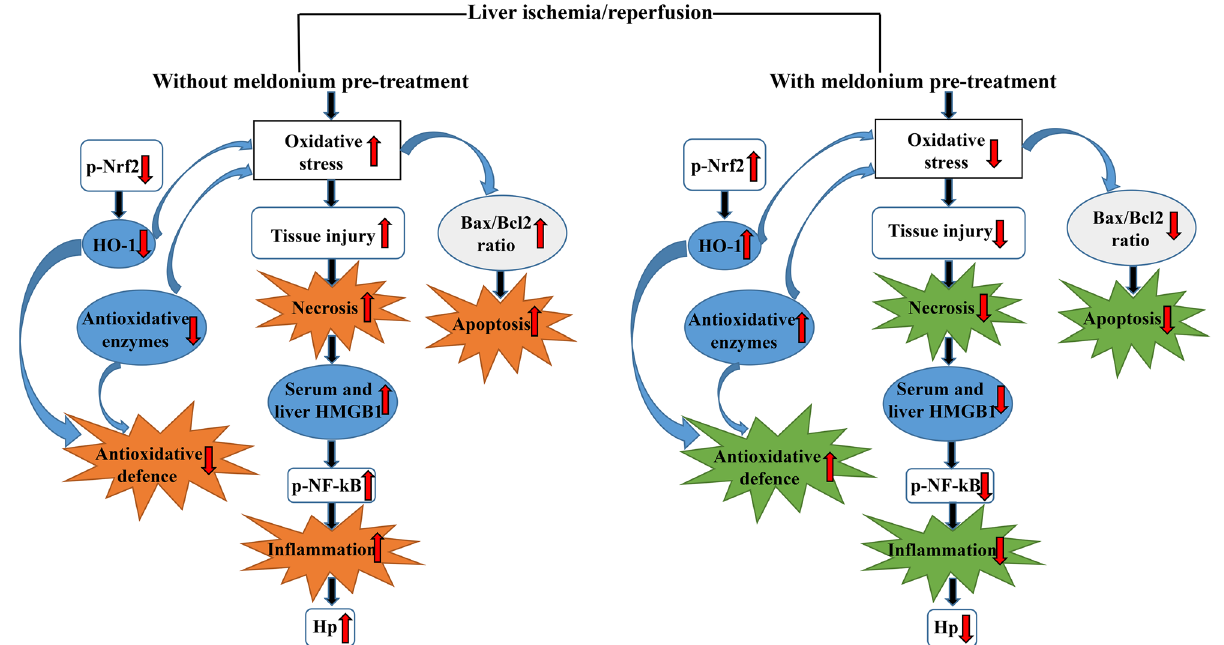
Figure 3. The summarised effects of meldonium pre-treatment on the liver ischemia/reperfusion. Meldonium pre-treatment improves the antioxidative defence through the increased hepatic activation of the nuclear factor erythroid 2-related factor 2 (p-Nrf2) and consequently hepatic haem oxygenase 1 (HO-1) expression, and activity of endogenous antioxidant enzymes. Thereby inhibits oxidative burst, tissue injury and cell necrosis, manifested by decreased expression of serum and liver high mobility group box 1 (HMGB1). Meldonium also reduces inflammatory cascade, as evident by decreased activation of the nuclear factor kappa-light-chain- enhancer of activated B cells (p-NF-kB p65) by phosphorylation along with decreased haptoglobin (Hp) expression. Simultaneously, meldonium attenuates apoptosis by decreasing the ratio of pro-apoptotic Bax and anti-apoptotic